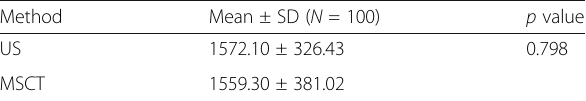
Table 1 Comparison of average liver volume by US and semi- automated CT volumetry